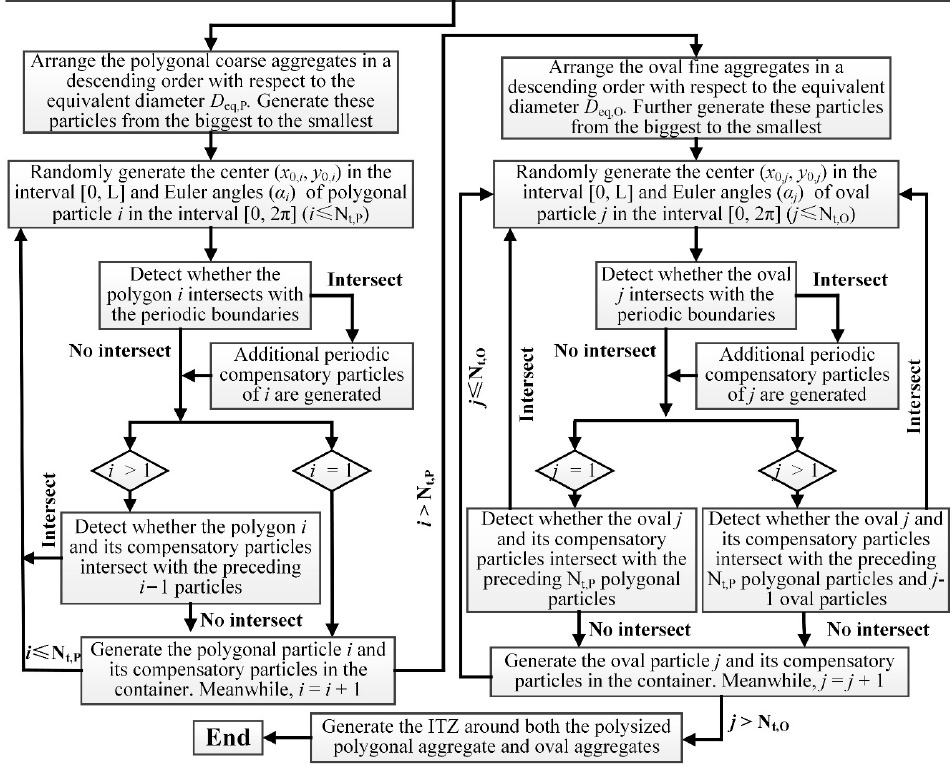
Figure 4. The flowchart of the procedure for generating the 2D models of polyphase concrete.